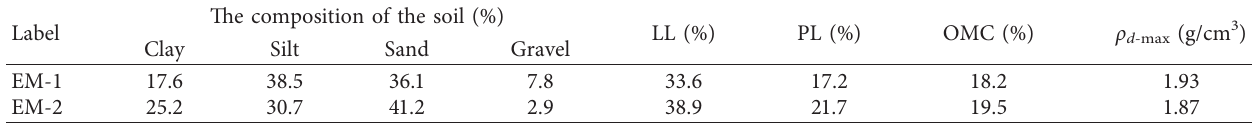
Table 1: Physical parameters of soil.